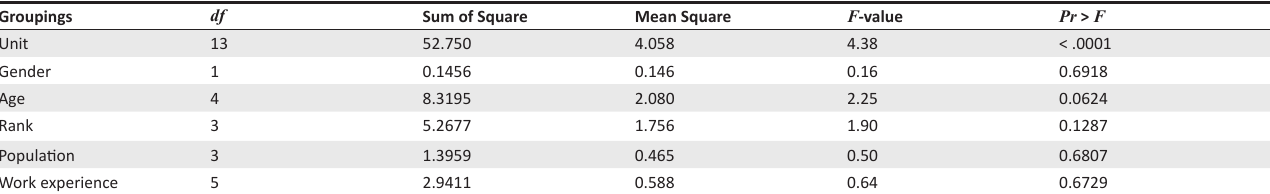
TABLE 18: Factor 3 (Achievement orientation):